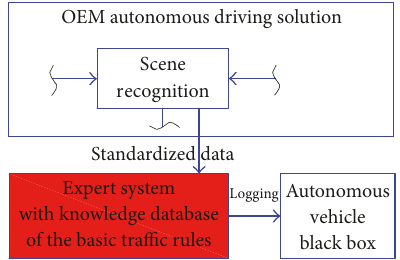
Figure 9: Accountability of autonomous